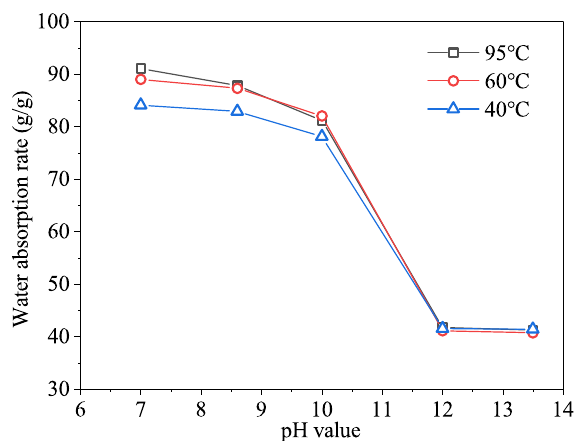
Figure 4. The absorption rates of the SAP at various temperatures and pH